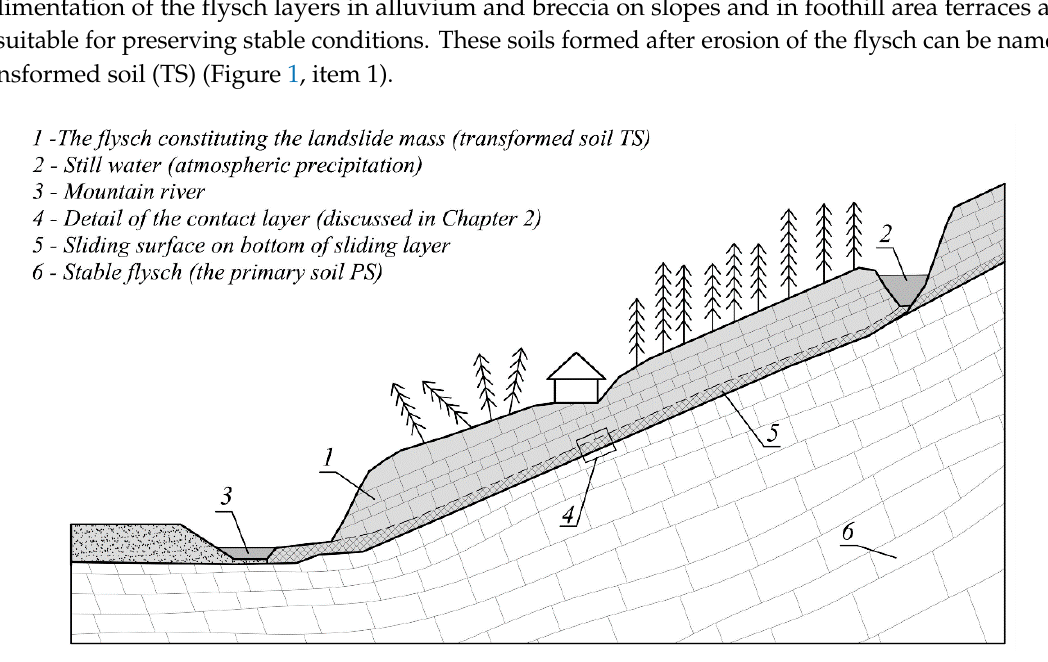
Figure 1. Typical cross-section of a landslide in a flysch structure.